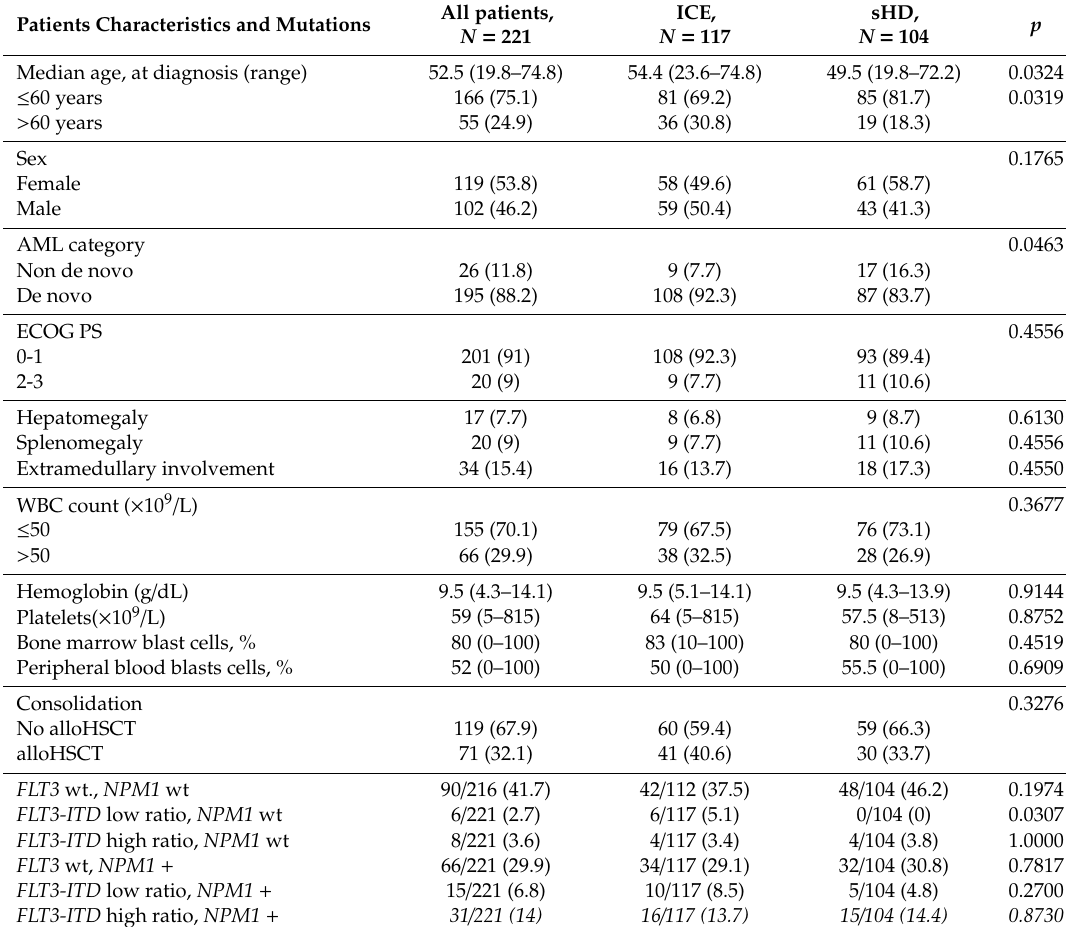
Table 1. Patients characteristics according to induction